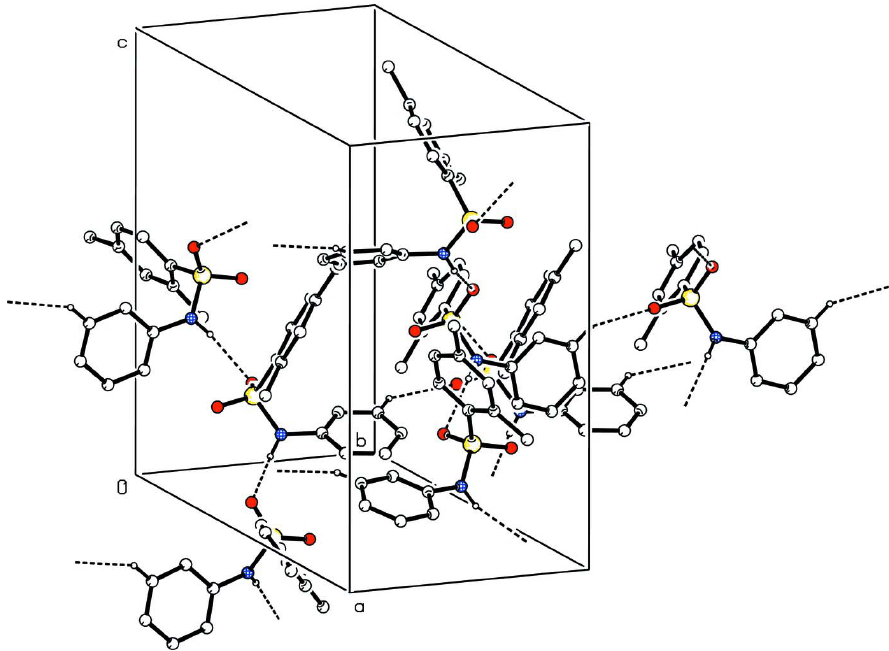
Figure 2 Molecular packing of the title compound with hydrogen bonding shown as dashed lines. H-atoms not involved in hydrogen bonding have been